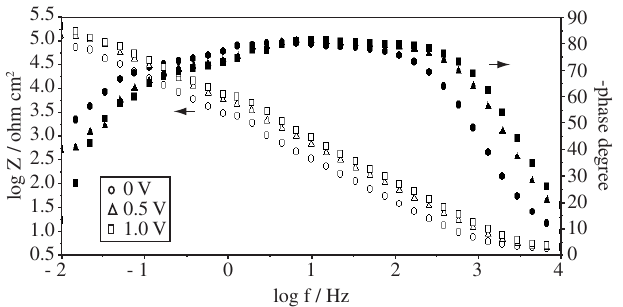
Figure 9. Bode plots of Ti obtained in the presence of chloride after anodic polarization at 0 ( ● ), 0.5 ( ▲ ) and 1.0 ( ■ ) V.